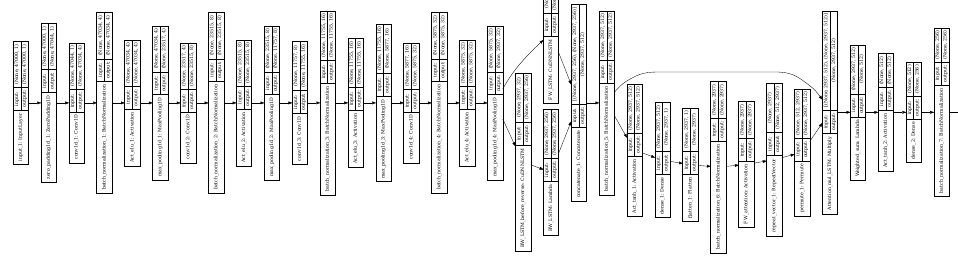
Figure 30: Network for desynchronized